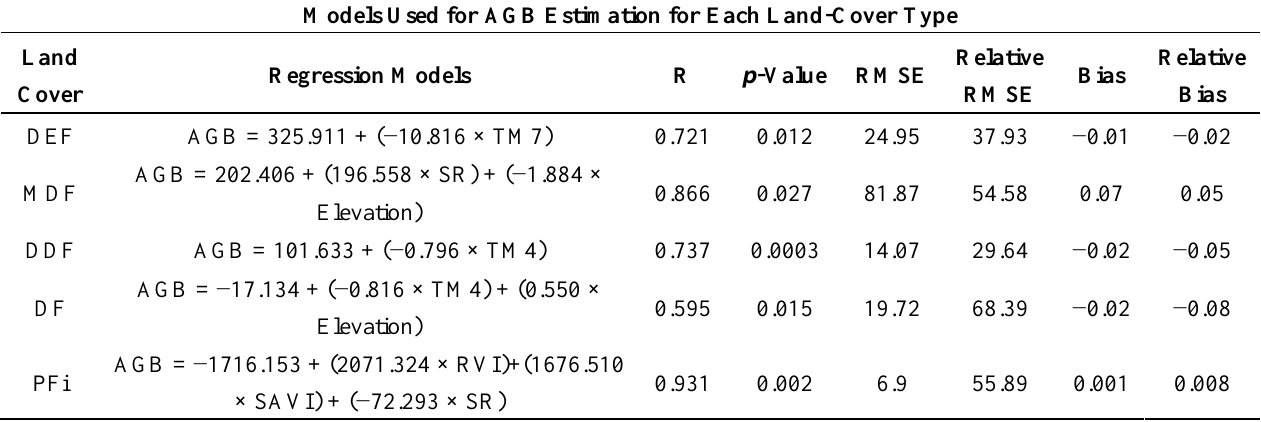
Table 10. Models used for AGB estimation (t/ha) for each land-cover type. Models Used for AGB Estimation for Each Land-Cover Type